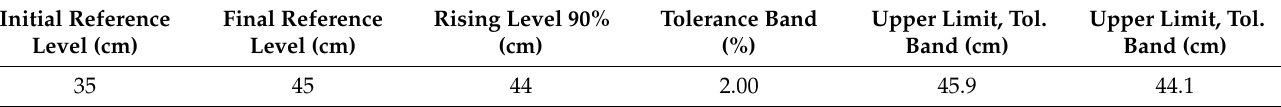
Table 4. Simulation parameters for reference leap from 35 to 45 cm scenario.